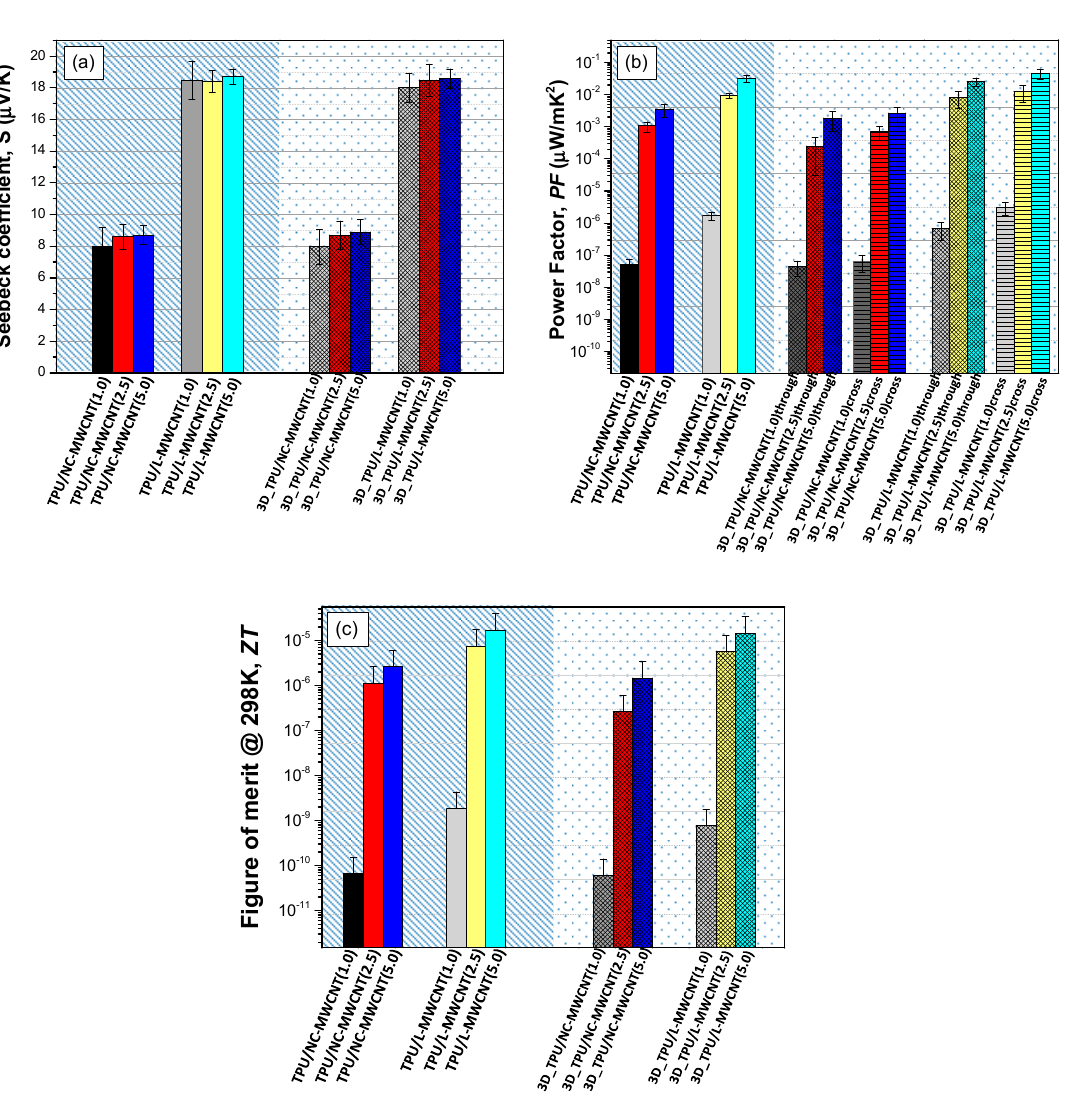
Figure 7. ( a ) Seebeck coe ffi cient of TPU / NC-MWCNT and TPU / L-MWCNT nanocomposites prepared by compression moulding of the corresponding precursor filaments, and ( b ) PF values of the compression moulded as well as the 3D printed TPU / MWCNT nanocomposites at 1.0, 2.5 and 5.0 wt.% MWCNT content, considering the through- and cross-layer-measured electrical conductivities (Seebeck coe ffi cient arising only from the CNT material is the same in all measured directions since it is an inherent property of the NW- and L-MWCNTs, respectively), ( c ) Figure of merit ( ZT ) of the compression moulded, as well as the 3D printed TPU / MWCNT nanocomposites (1.0, 2.5 and 5.0 wt.% MWCNT